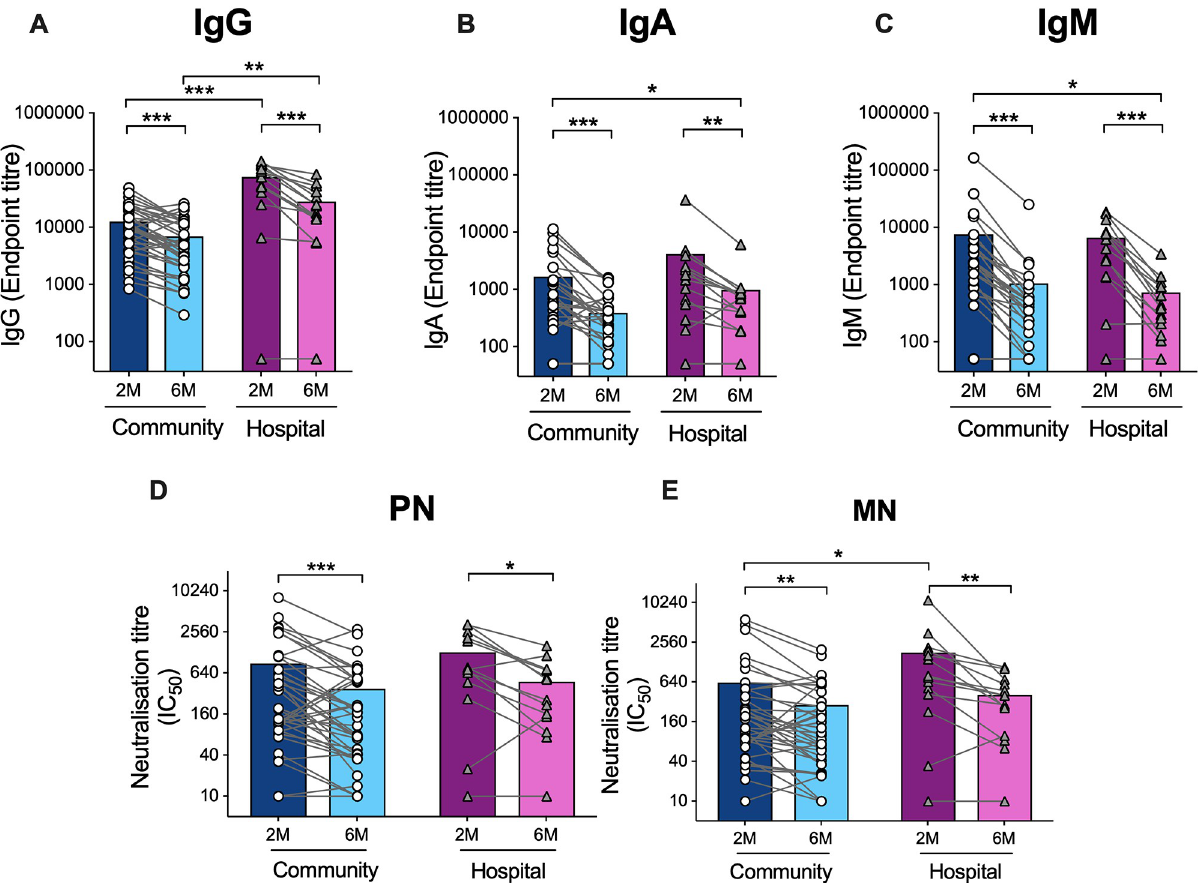
Fig 1. SARS CoV-2 specific antibody responses by severity of illness. Comparison of the SARS-CoV-2 spike-specific and neutralization antibody titers between community and hospitalized patients is shown, Spike-specific IgG(A), IgA (B), IgM (C). Serum was collected at 2- and 6-months post- infection, and spike-specific responses were measured by ELISA. The neutralization antibodies were measured by pseudotype neutralization (PN) (D) and microneutralization (MN) (E) assays. Each symbol represents the SARS-CoV-2 spike- specific antibody responses of one individual, and the lines connect the paired samples at 2 and 6 months. The bars represent the geometric mean titers. A nonparametric paired t-test (Kruskal–Wallis), was used to compare 2- and 6-month samples ( � = P < 0.05, �� P <